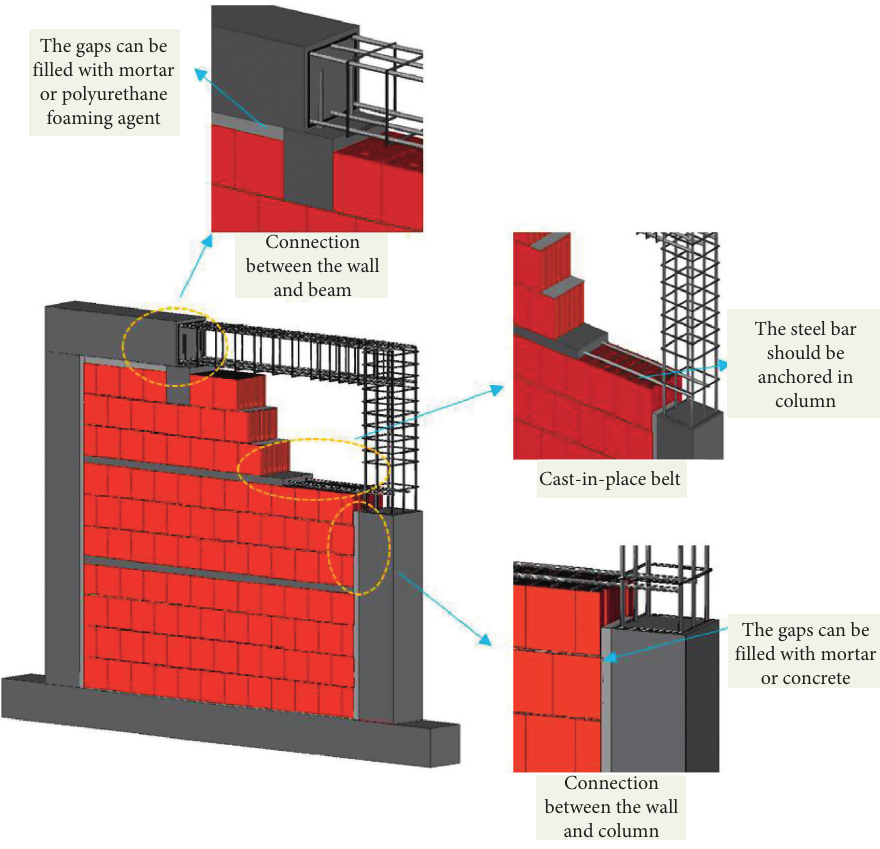
Figure 14: Three-dimensional model and its